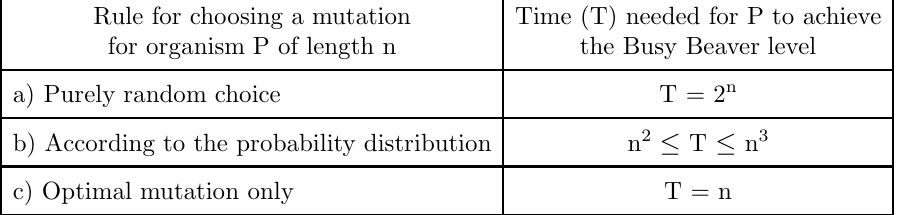
Rule for choosing a mutation Time (T) needed for P to achieve for organism P of length n the Busy Beaver